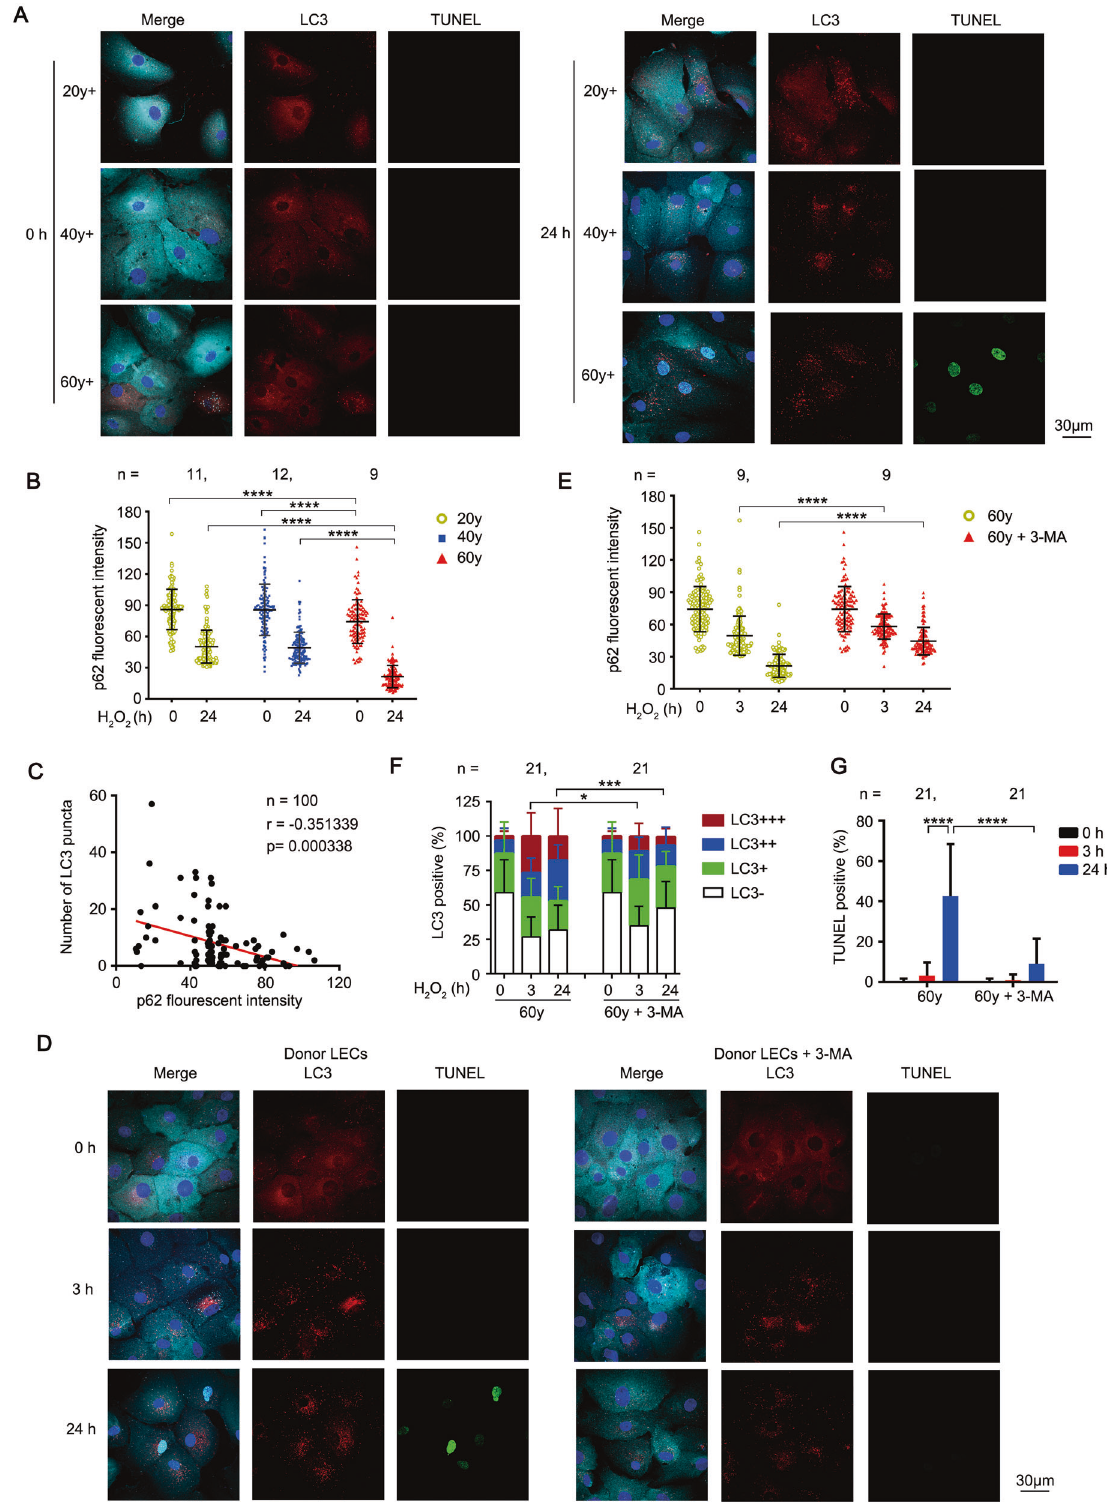
RNA isolation and real-time PCR Total RNA was extracted from HLE-B3 cells using TRIzol reagent